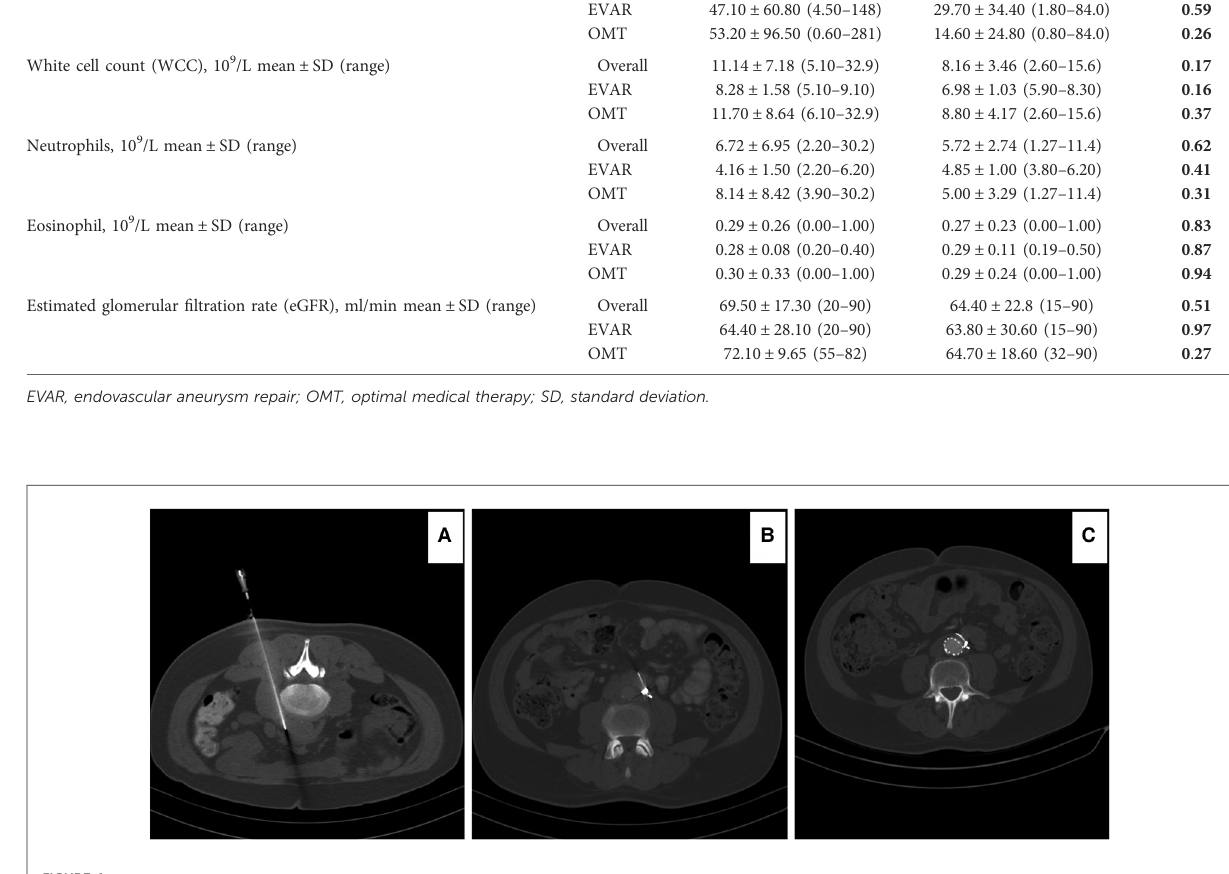
Figure 5 (log-rank test: χ ² = 2.25; P = 0.13). All EVAR patients went off all of the painkillers.